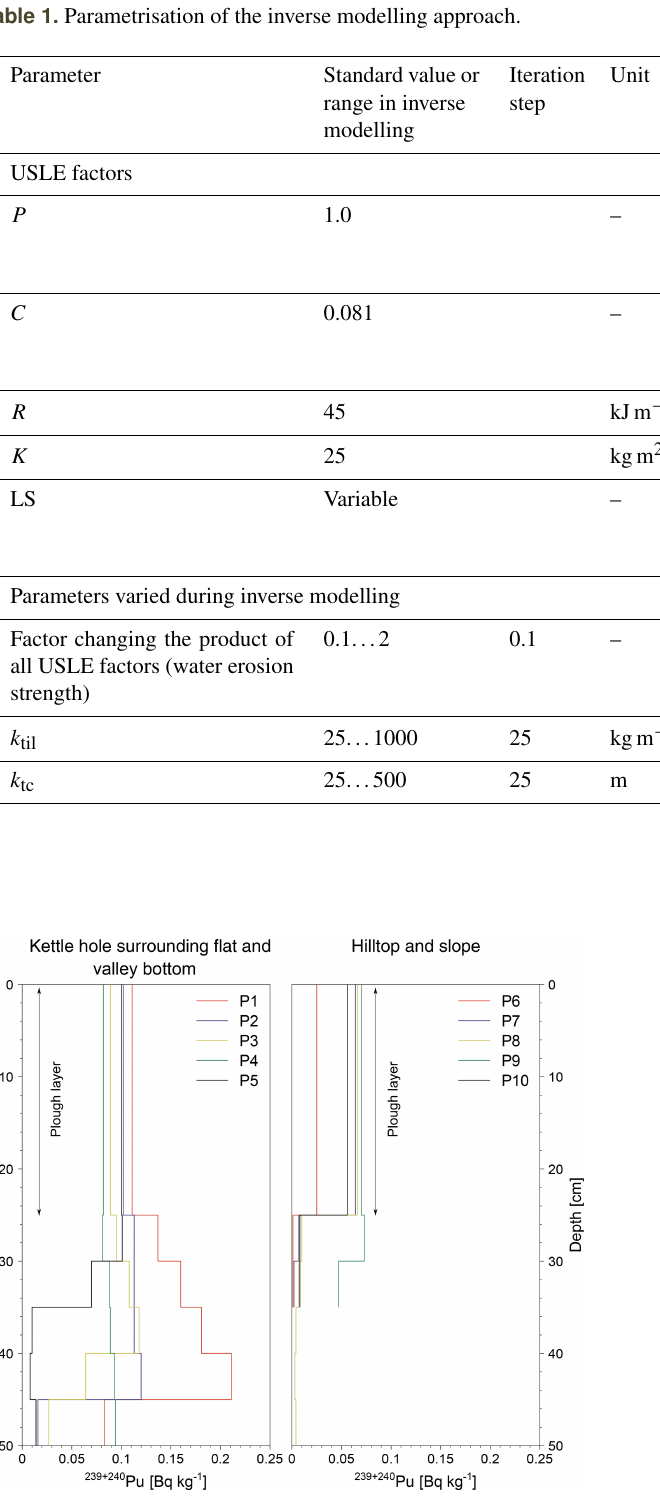
Figure 3. Depth distribution of 239 + 240 Pu at different geomorpho- logical positions. Locations P1 to P10 are given in Fig. 1.